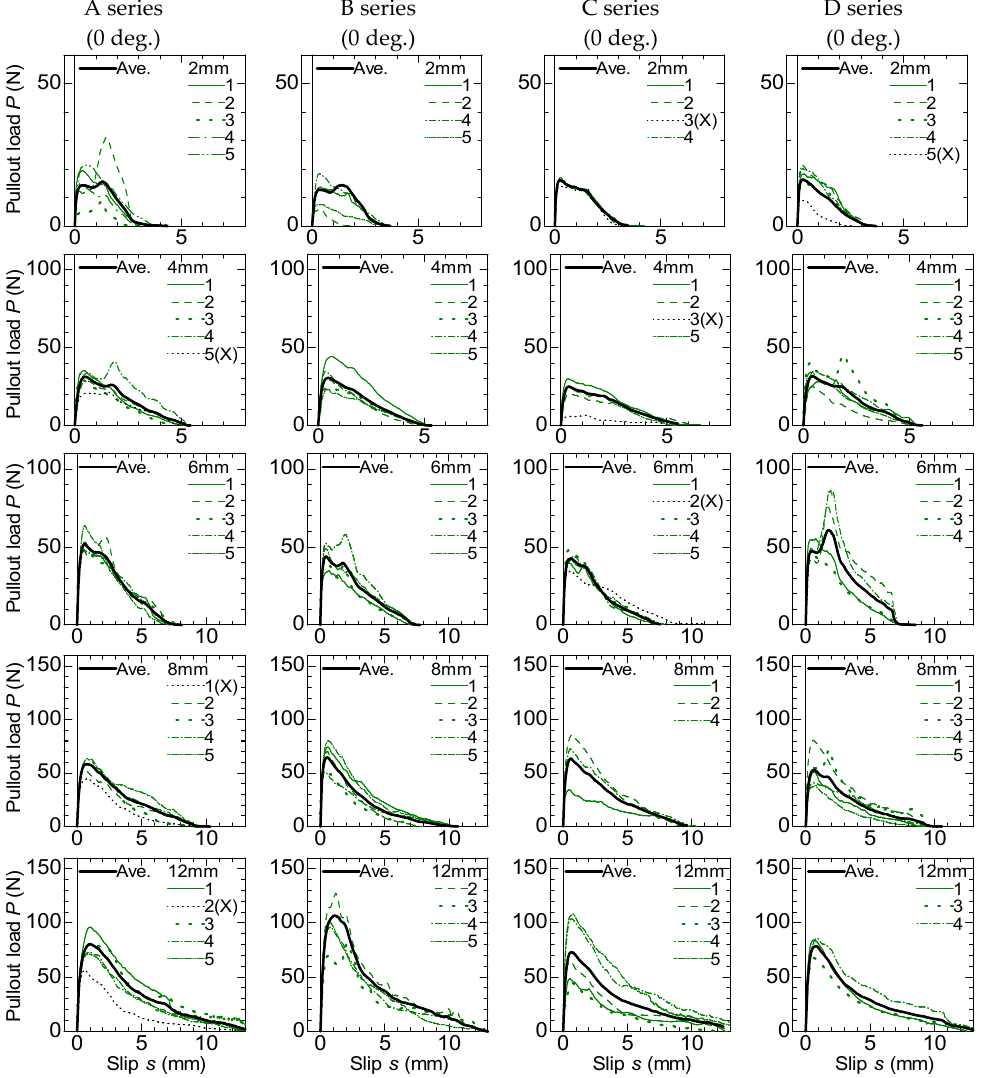
Figure 7. Pullout load–slip curve (no-inclined angle specimen).